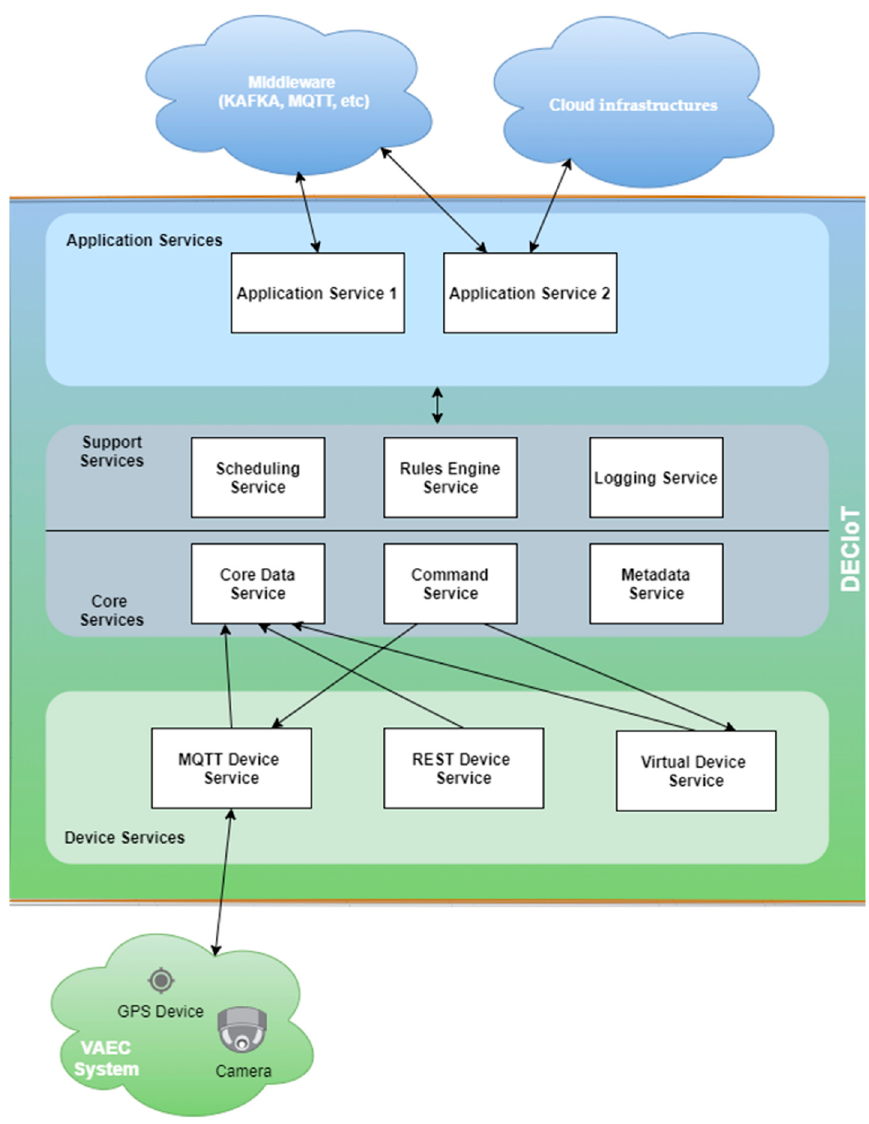
Figure 3. DECIoT